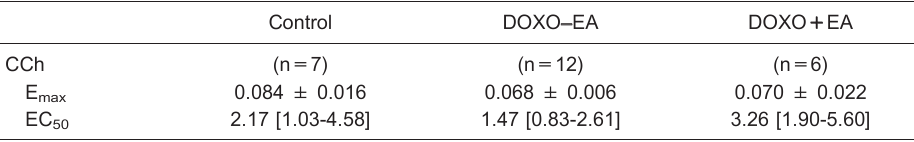
Data are reported as means±SE or geometric mean [95%CI]. DOXO––EA: doxorubicin without esophageal atresia; DOXO++EA: doxorubicin with esophageal atresia; CCh: carbachol; E max : maximum effect values in g/mg tissue mass; EC 50 : half-maximal effective